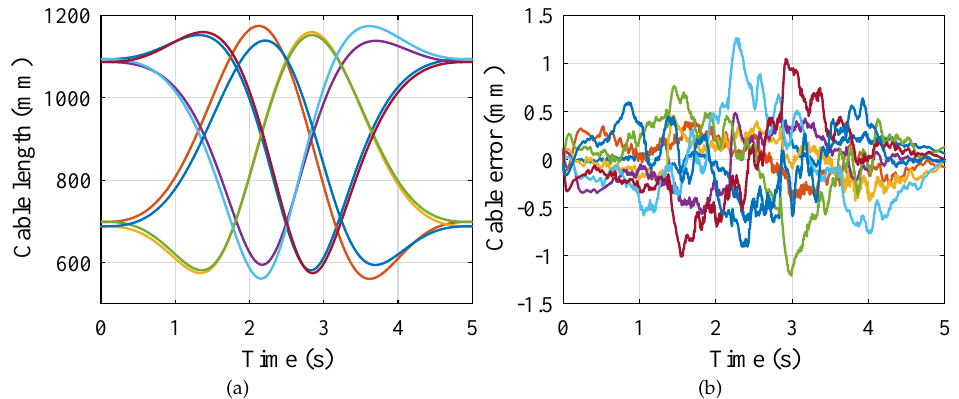
Figure 8. Trajectory tracking performance in joint space. ( a ) Desired cable lengths. ( b ) Cable length errors.